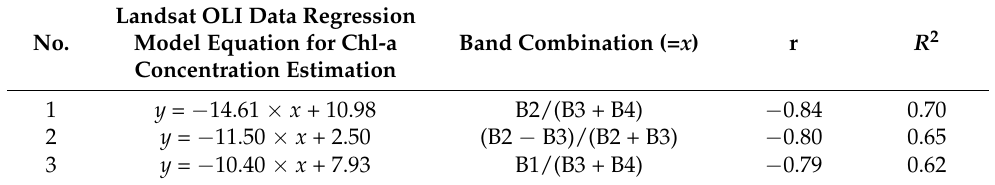
Table 6. Regression model for the retrieval of Chl-a concentration using Landsat OLI training datasets.